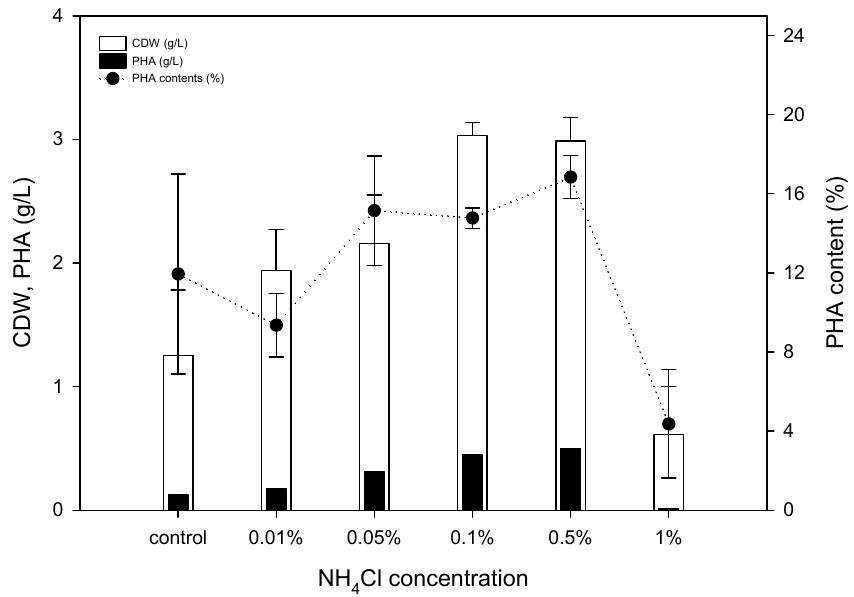
Figure 5. Effect of C/N ratio variance for PHA production. NH 4 Cl was used in the range of 0.01 to 1%, and 2% of coffee oil was used in the culture as a constant.